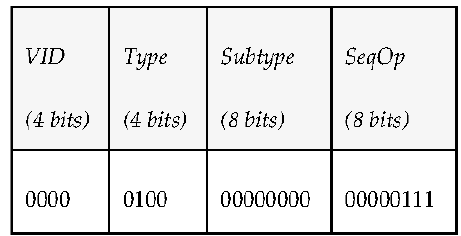
Figure 12. PDU used for CDT discovery.